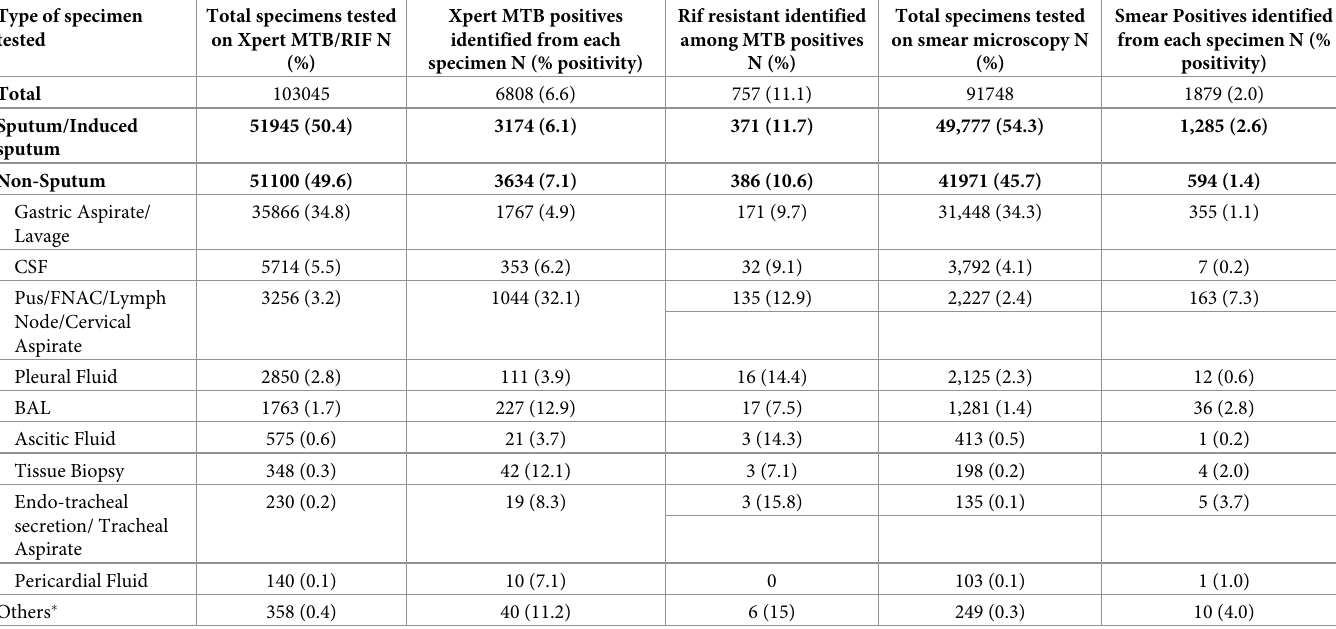
Table 3. Specimen type analysis and comparison between Xpert MTB/RIF and smear microscopy